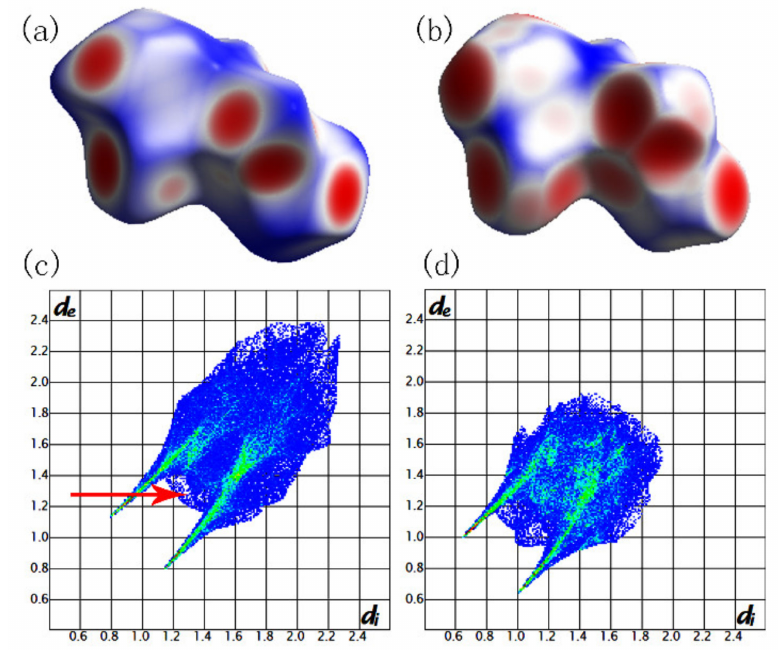
Figure 3. Hirshfeld surfaces mapped with d norm and fingerprint plots for malonamide at ambient pressure( a , c ) and at 10 GPa ( b , d ). Reprinted with permission from Ref. [71]. Copyright 2015 Royal Society of